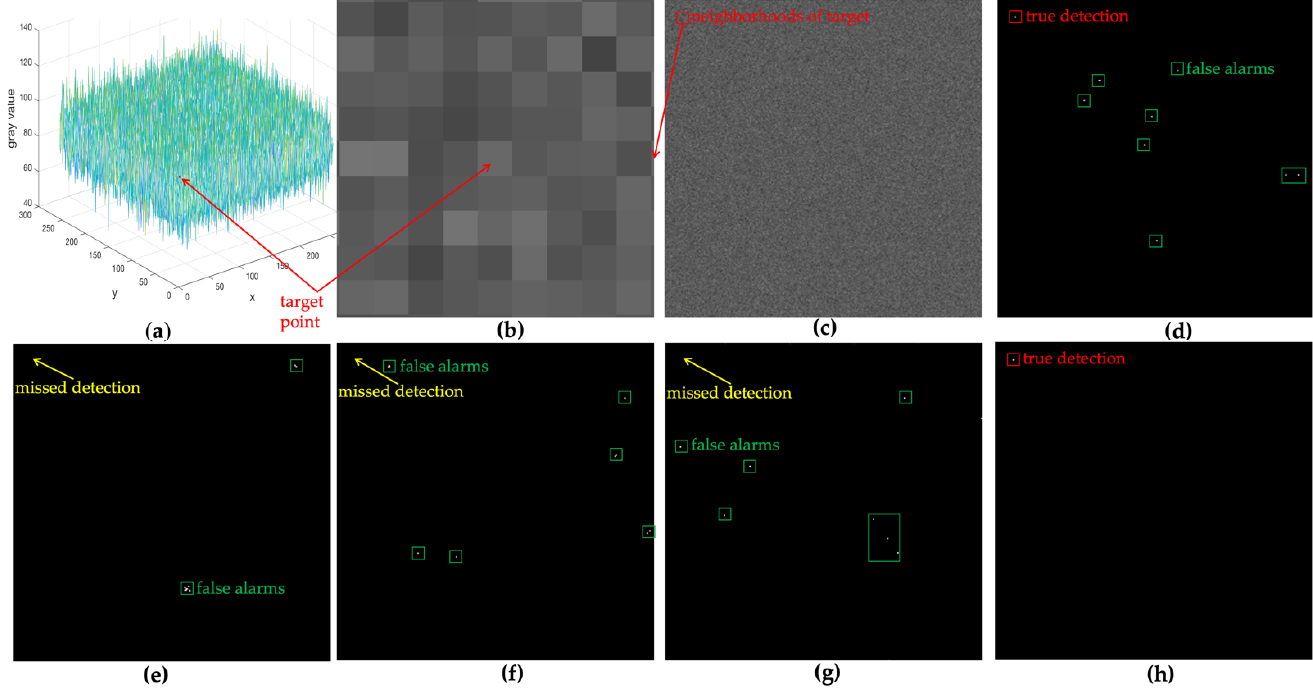
Figure 10. ROC curves of different methods under different data. ( a ) SCR is 1.5; ( b ) SCR is 1.4.